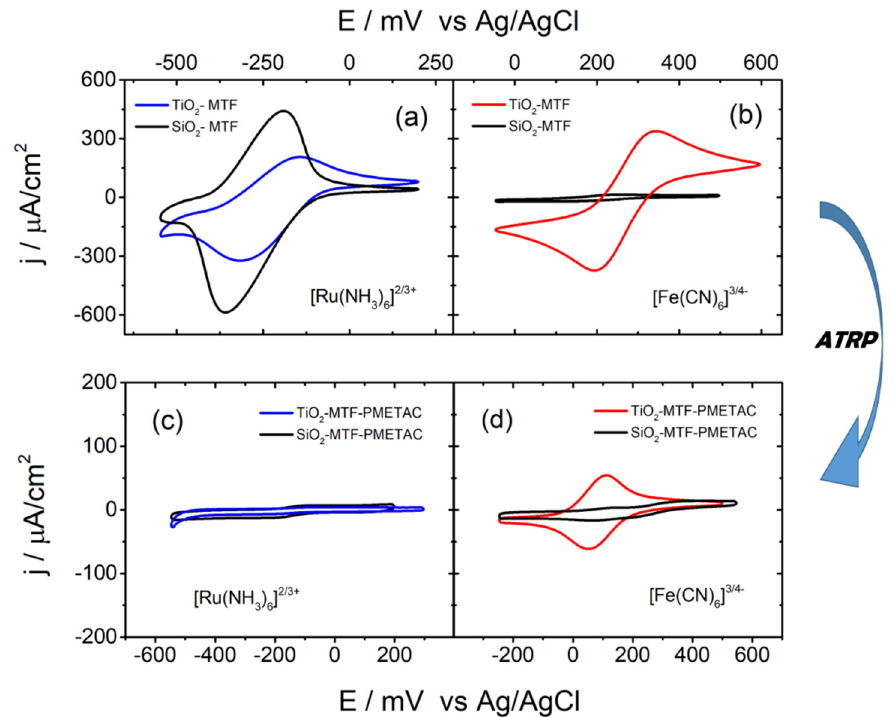
Figure 5. Cyclic voltammetry of [Ru(NH 3 ) 6 ] 3+/2+ ( a , c ) and [(Fe(CN) 6 ] 3 − /4 − ( b , d ) for an ITO electrode covered with SiO 2 ‐ MTF and TiO 2 ‐ MTF. Measurements were conducted at pH = 5.5. CV measure ‐ covered with SiO 2 -MTF and TiO 2 -MTF. Measurements were conducted at pH = 5.5. CV measurements ments on MTF are shown in ( a , b ), and on PMETAC ‐ modified MTF are shown in ( c , d ). on MTF are shown in ( a , b ), and on PMETAC-modified MTF are shown in ( c , d